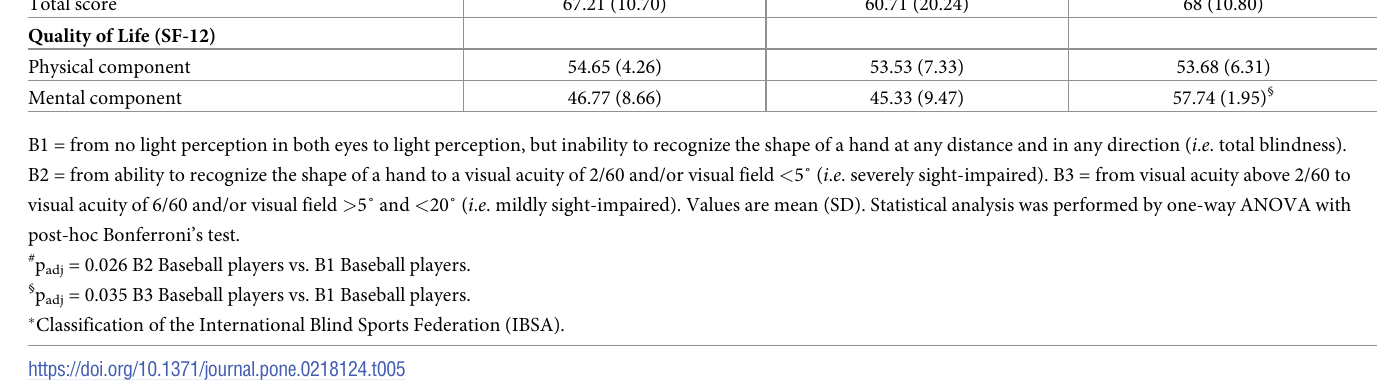
B1 = from no light perception in both eyes to light perception, but inability to recognize the shape of a hand at any distance and in any direction ( i . e . total